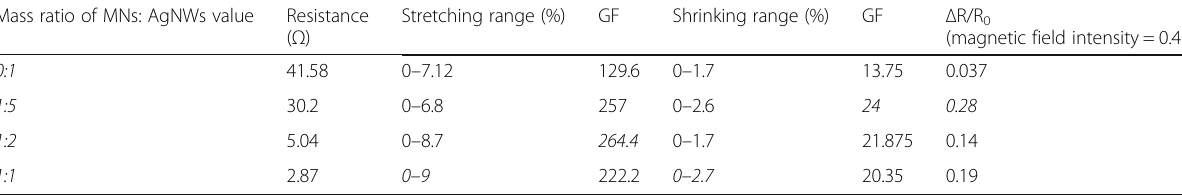
Table 1 Parameters of the strain sensors based on different ratios of MNs and AgNWs Mass ratio of MNs: AgNWs value